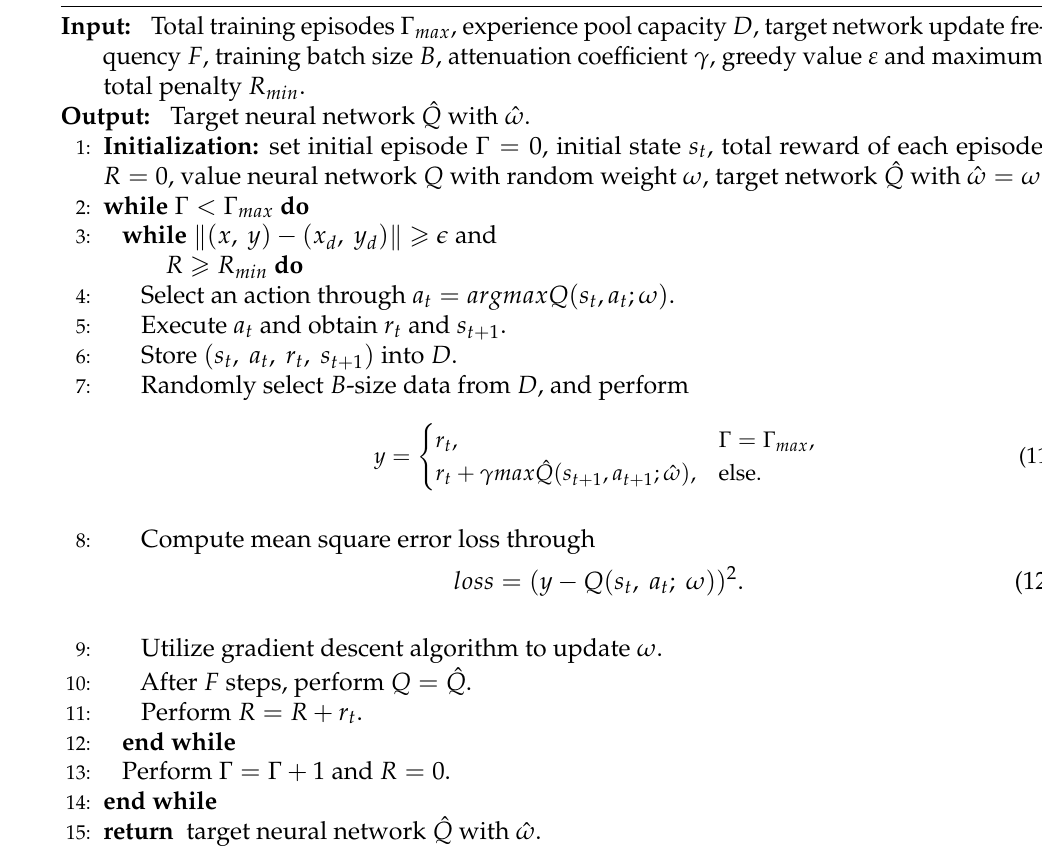
Algorithm 1 DQN training